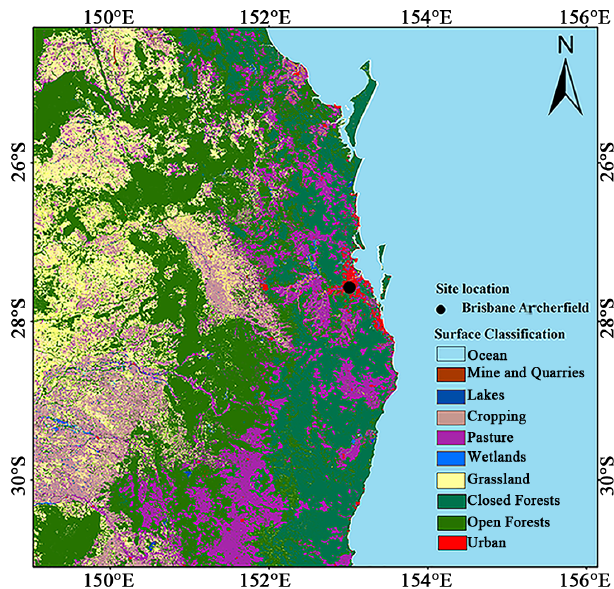
Figure 1. The map of eastern Australia with land-cover types. The observation site is marked by a black